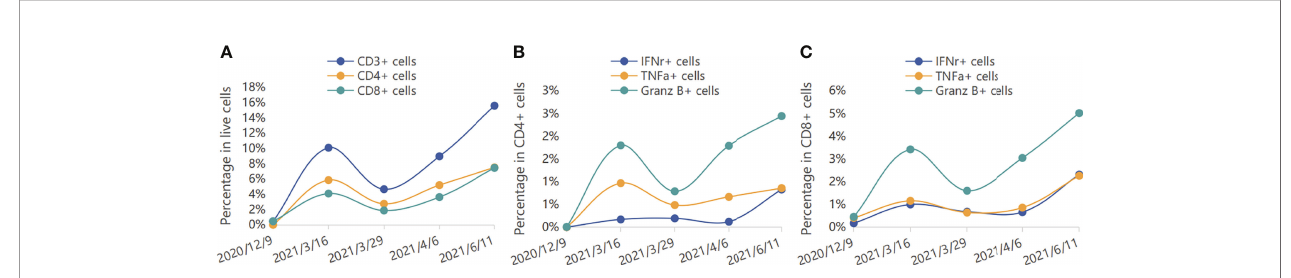
FIGURE 3 | Reconstitution kinetics in immune cells in the peripheral blood. (A) The percentages of CD3 + , CD4 + , and CD8 + cells in live cells during treatment. (B) The percentages of IFNr + , TNFa + , and Granz B + cells in CD4 + cells during treatment. (C) The percentages of IFNr + , TNFa + , and Granz B + cells in CD8 + cells during treatment.